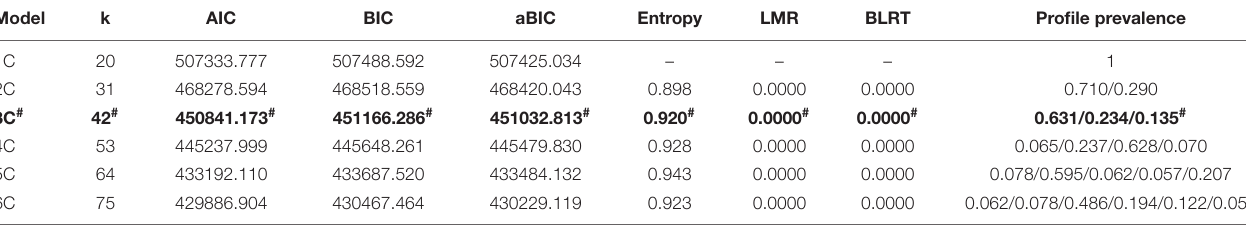
TABLE 2 | Model fit indices for one- to six-latent profile solutions and corresponding profile prevalence.